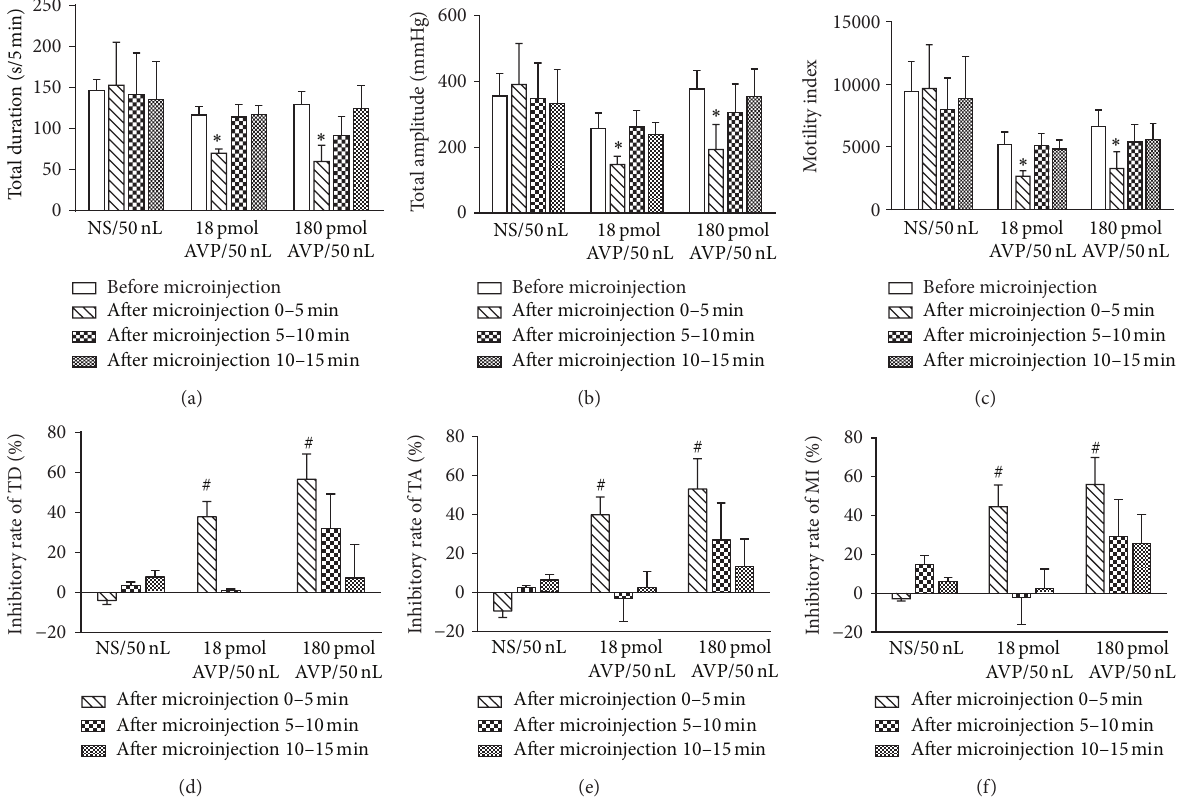
Figure 3: Representative data for gastric motility before and after microinjection of AVP (18 and 180pmol) or normal saline (NS) into the DMV. Mean data of total duration (a), total amplitude (b), and motility index (c) before microinjection and after microinjection 0–5 min, 5–10 min, and 10–15 min. Average inhibitory rate of total duration (d), total amplitude (e), and motility index (f) in the first 5 min, second 5 min, and third 5 min. ∗ 𝑃 < 0.05 , versus before microinjection; # 𝑃 < 0.05 , versus NS group in the same period.